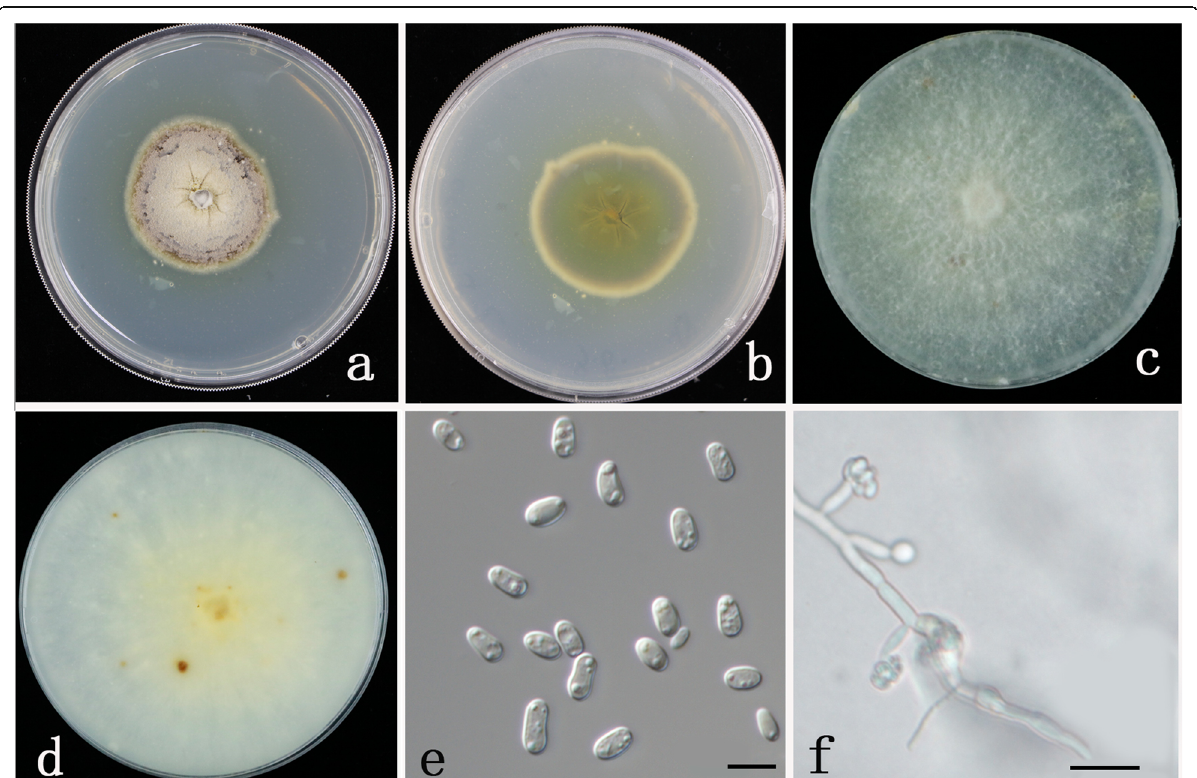
Fig. 3 Fungi isolation and morphological characterization. a , b Phaeoacremonium minimum grown on PDA media for 14 days. The front ( a ) and reverse ( b ) sides of the culture plate. c , d Fomitiporia punicata grown on PDA media for 18 days. The front ( c ) and reverse ( d ) sides of the culture plate. e , f Conidia and conidiogenous cells of P. minimum . Bar = 10 μ m in ( e ); Bar = 20 μ m in ( f